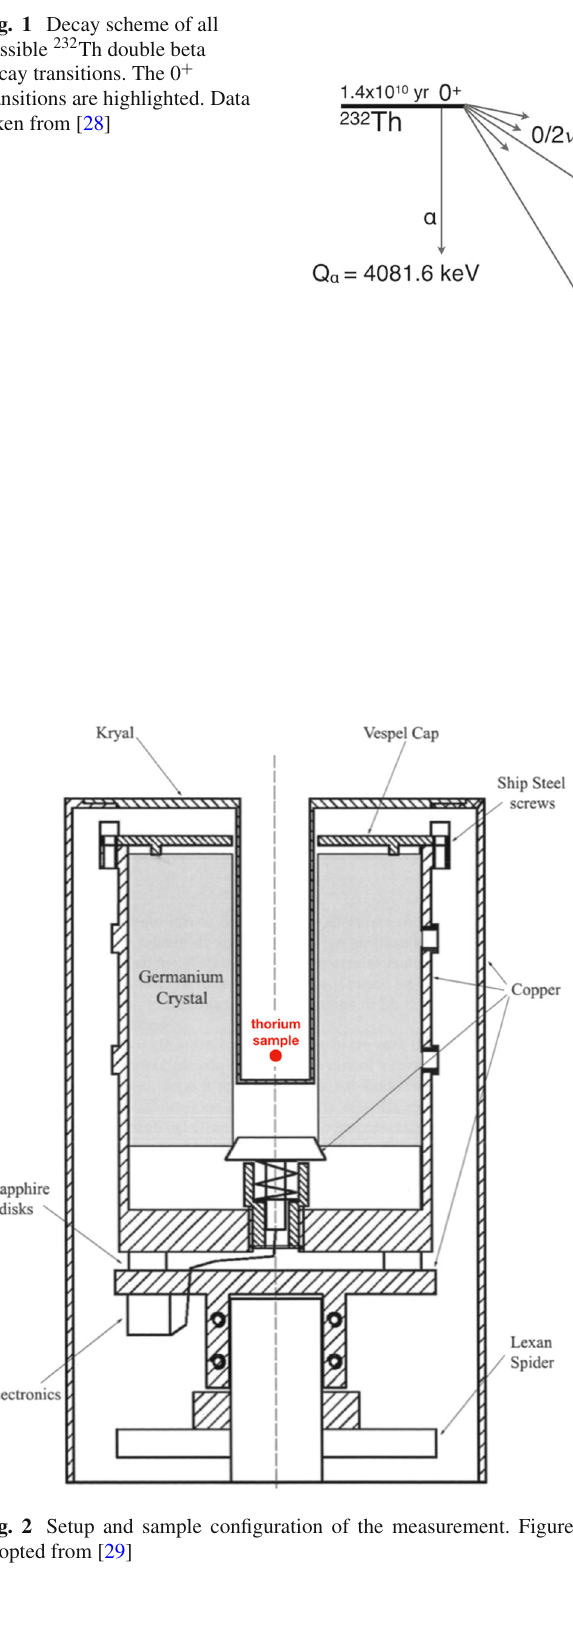
Fig. 1 Decay scheme of all possible 232 Th double beta decay transitions. The 0 + transitions are highlighted. Data taken from [28]